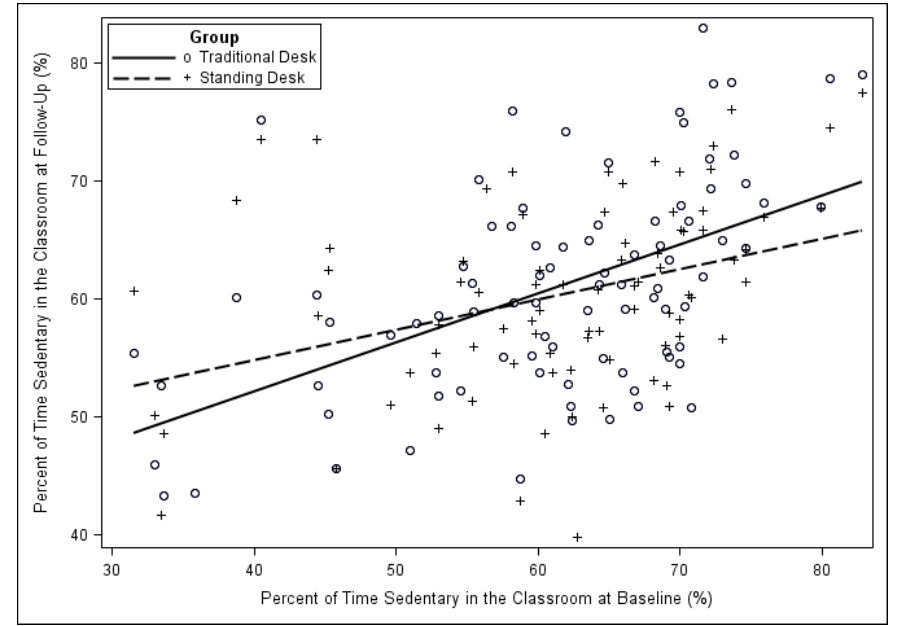
Figure 1. Relationship between sedentary behavior at baseline and follow-up for students using traditional and stand-biased desks. (+ = Standing Desk; ○ = Traditional Desk).